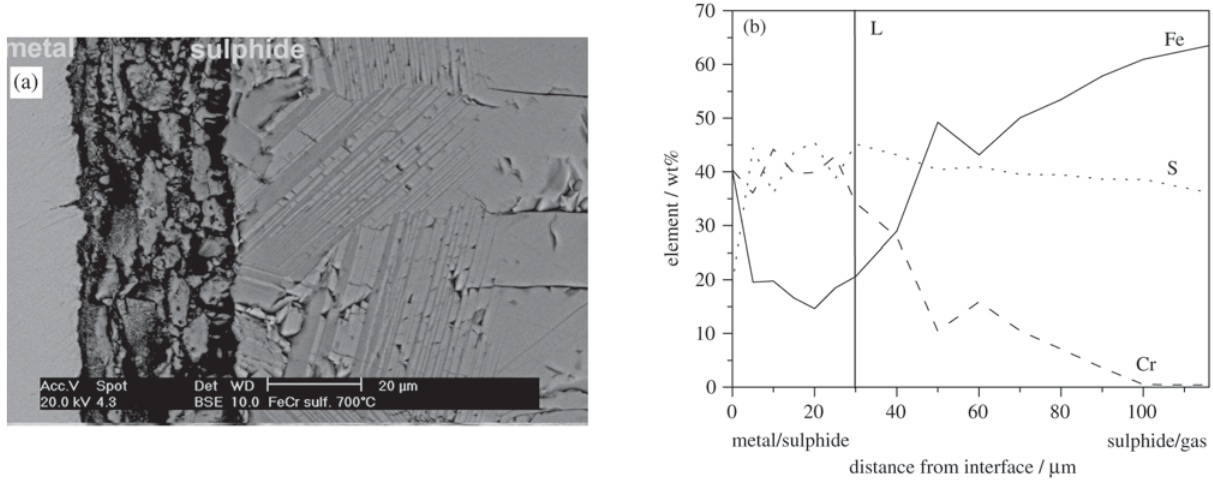
Figure 3. a) Cross-section of FeCr alloy sulphidised at 700 °C; b) composition profile through